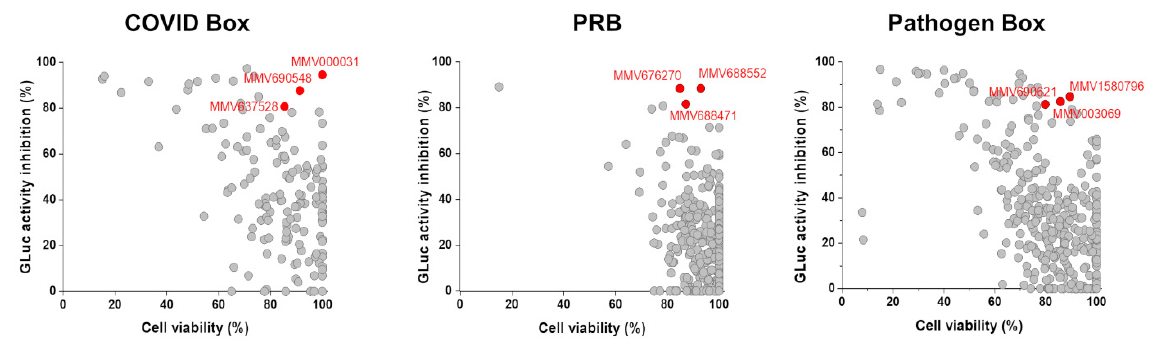
Figure 2. Replicon-based HTS for the COVID Box, Pandemic Response Box (PRB), and Pathogen Box. Scatter plots for the screening results of the 960 compounds in the primary screenings at 10 µM. In y-axis, the relative GLuc activity inhibition, and in x-axis, the relative cell viability. Selected compounds are highlighted in red and identified by their MMV code.